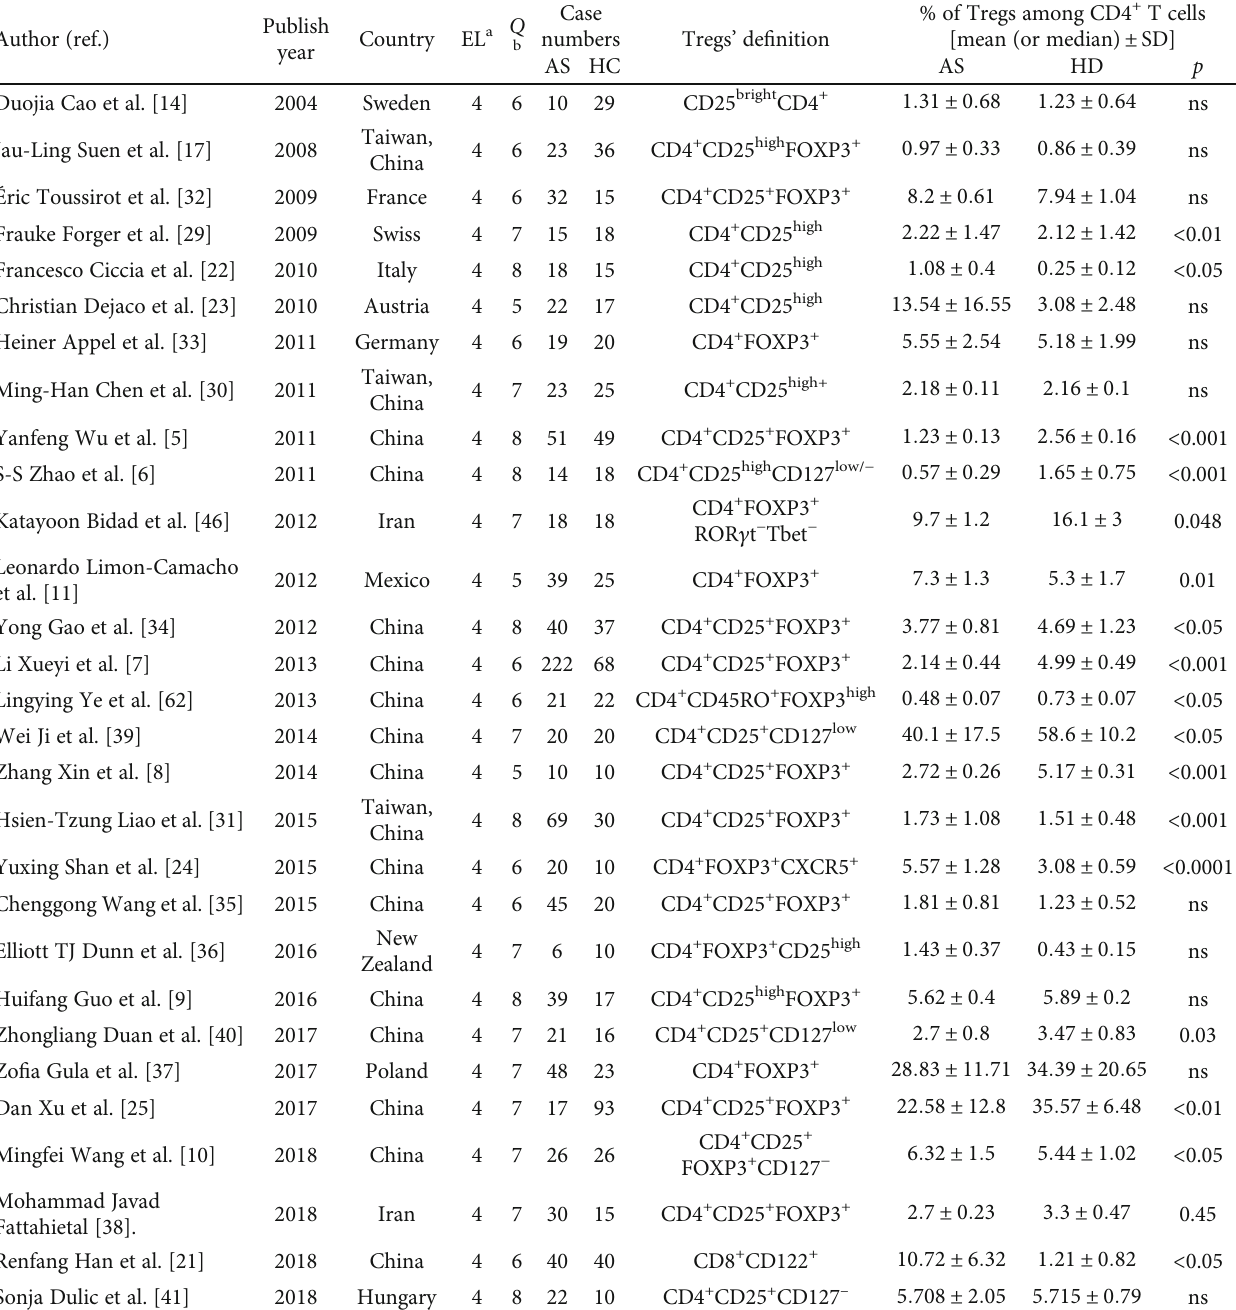
Table 1: Characteristics of the individual studies included in the